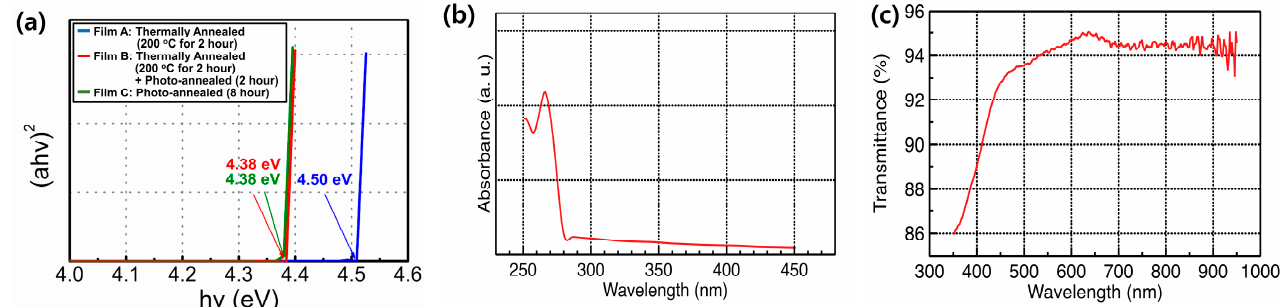
Figure 5. ( a ) Optical bandgap of Y 2 O 3 films obtained under different annealing treatments; ( b ) light- absorption characteristics of Y(NO 3 ) 3 ·4H 2 O on a glass substrate; ( c ) transmittance spectra of ITO/glass substrate.